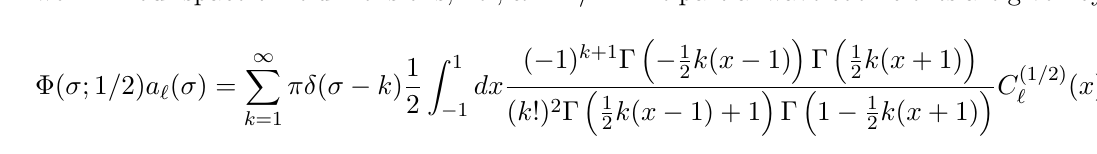
( − 1) k +1 Γ( − s 2 )Γ( k + s 2 ) ; s ) = P ∞ 1 2 k =1 ( k !) 2 Γ( s 2 +1)Γ( − k − s 2 +1)